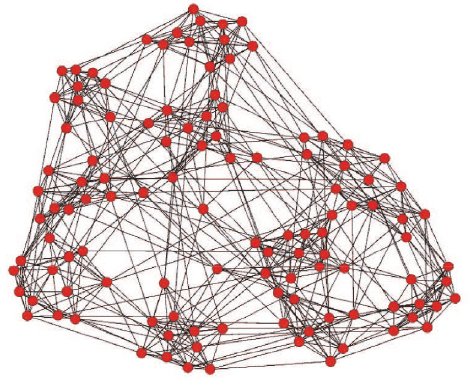
Figure 2: The graph of football network.